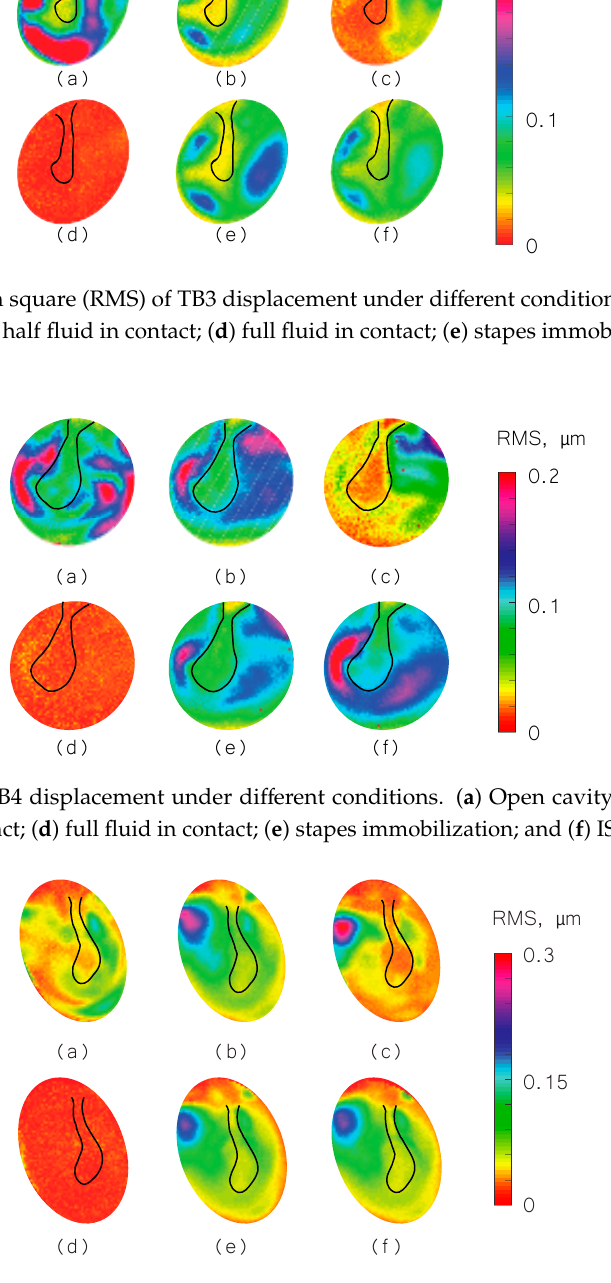
Figure 7. Umbo displacement of TB3 under different cases (umbo location is marked as the intersection of the solid black and dashed black lines in Figure 3a).